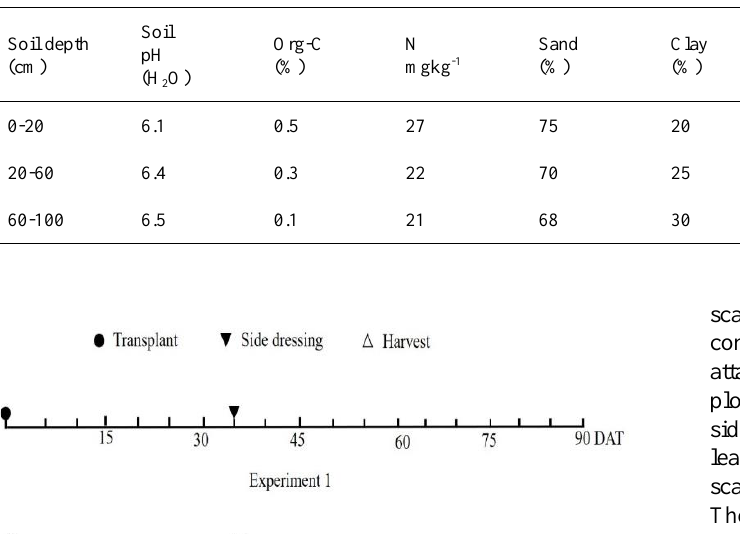
Figure 1. Study site location Table 1. Chemical and physical properties of the experimental soil